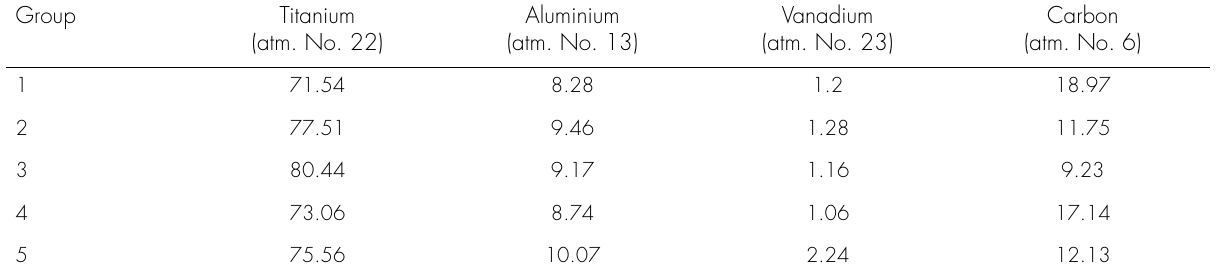
Table II. Atomic percentage composition (at. %) of the elements in each group of mini-implants according to EDAX.